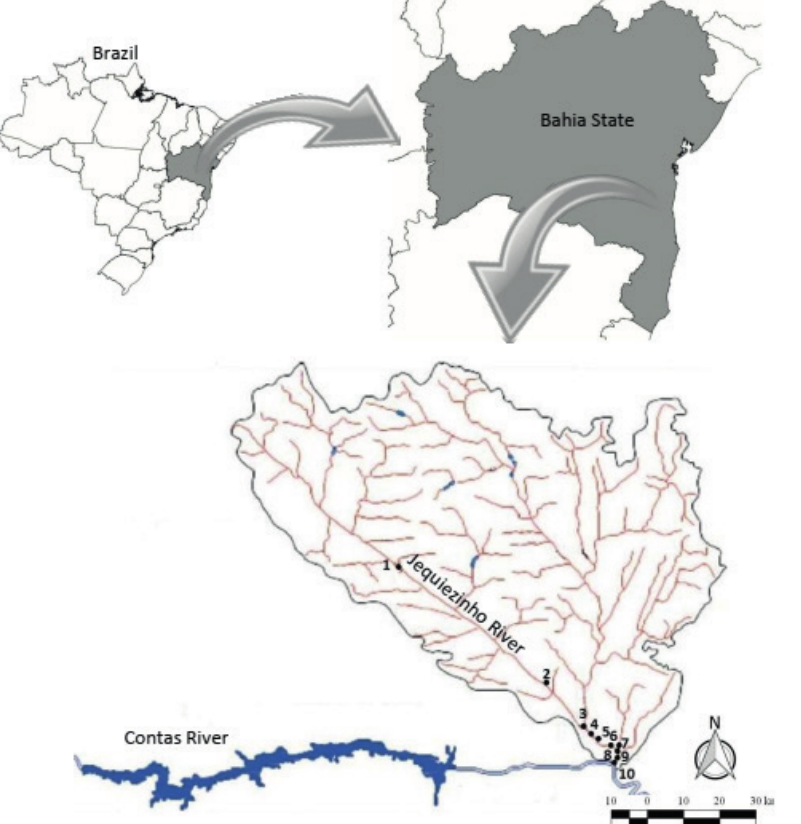
Figure 1. Sub-basin of the Jequiezinho River. Adapted from Magalhães et al.